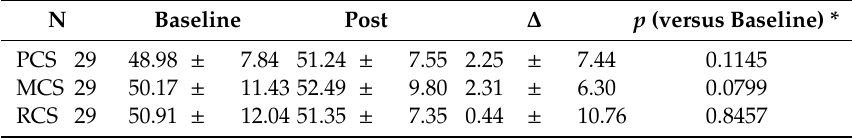
Table 4. Changes in the quality of life